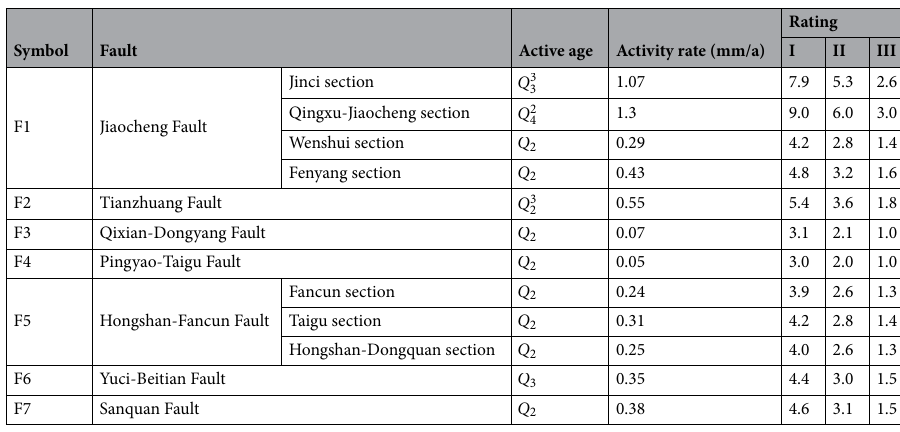
Table 4. Ratings of faults (the active age and activity rate of the faults are from Wang et al. 68 ).